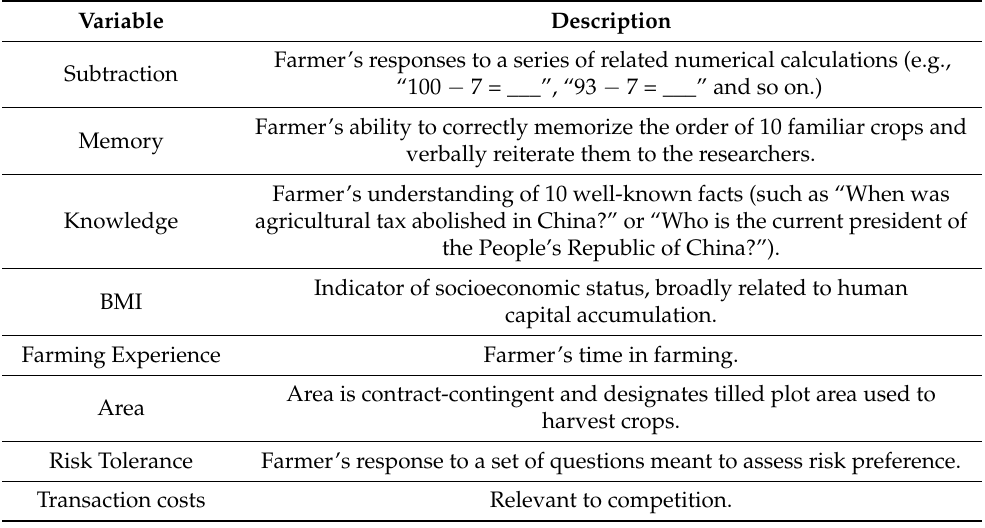
Table 2. Descriptions of